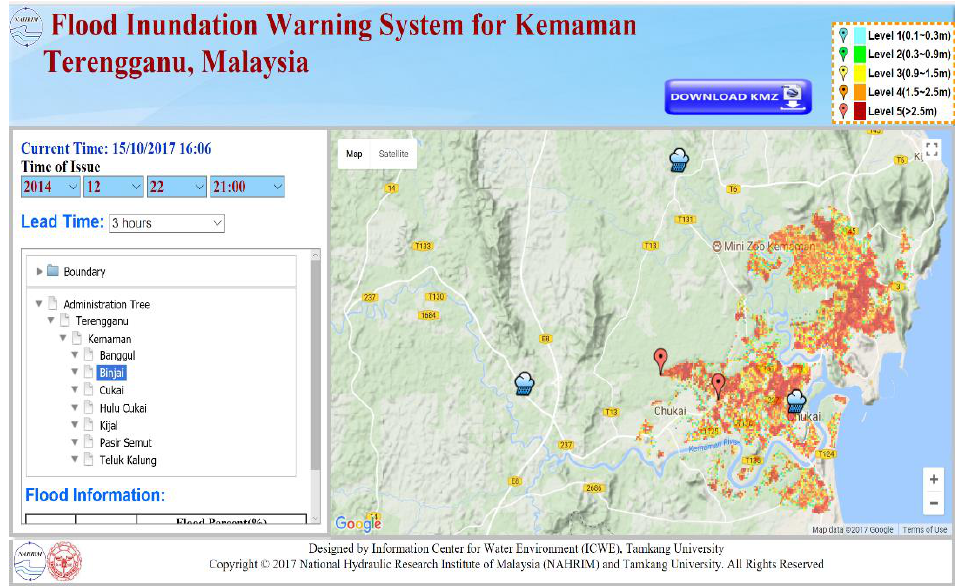
Figure 10. Regional flood inundation information on the designed Web.